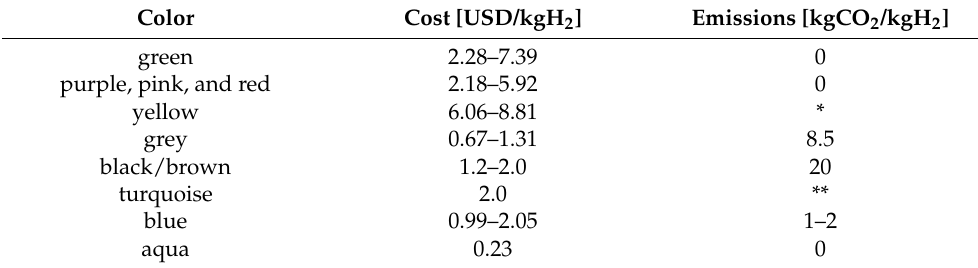
Table 2. Comparison between the hydrogen colors in terms of costs and carbon emissions. Color Cost [USD/kgH 2 ] Emissions [kgCO 2 /kgH 2 ] green 2.28–7.39 0 purple, pink, and red 2.18–5.92 0 yellow 6.06–8.81 * grey 0.67–1.31 8.5 black/brown 1.2–2.0 20 turquoise 2.0 ** blue 0.99–2.05 1–2 aqua 0.23 0 * Yellow hydrogen emissions depend on the location and its respective power mix. ** Turquoise hydrogen produces a solid carbon